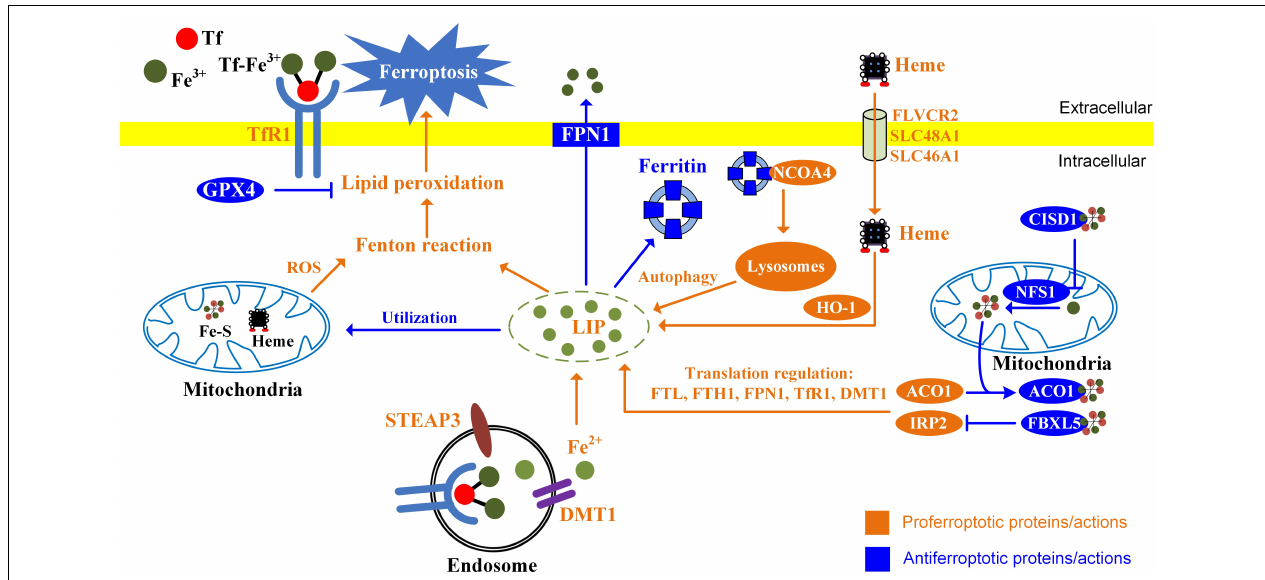
FIGURE 2 | Alterations of iron metabolism influence ferroptosis in cancer cells. The ways of increasing absorption, reducing iron storage, and limiting iron efflux contribute to ferroptosis. Endocytosis of diferric Tf is the major way for cellular iron uptake. In the endosomes, ferric iron is released from Tf, reduced by STEAP3, and transported to the cytosol through DMT1. Heme provides additional sources of iron through FLVCR2, SLC48A1, and SLC46A1 in the cell membrane. HO-1 catalyzes oxidative degradation of heme to liberate ferrous iron. Ferritin is a protein that stores iron, while NCOA4-mediated ferritinophagy promotes ferritin degradation and releases ferrous iron. Iron can be utilized for the synthesis of Heme and Fe-S clusters. Mitochondrial proteins regulating iron utilization (CISD1 and NFS1) negatively regulate ferroptosis. Iron-regulatory proteins ACO1 and IRP2 regulate ferroptosis by modulating FTL, FTH1, FPN1, TfR1, and DMT1 at the translational